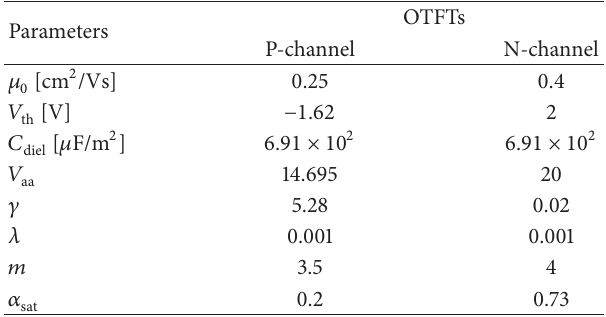
Table 1: Main parameters in the OTFT